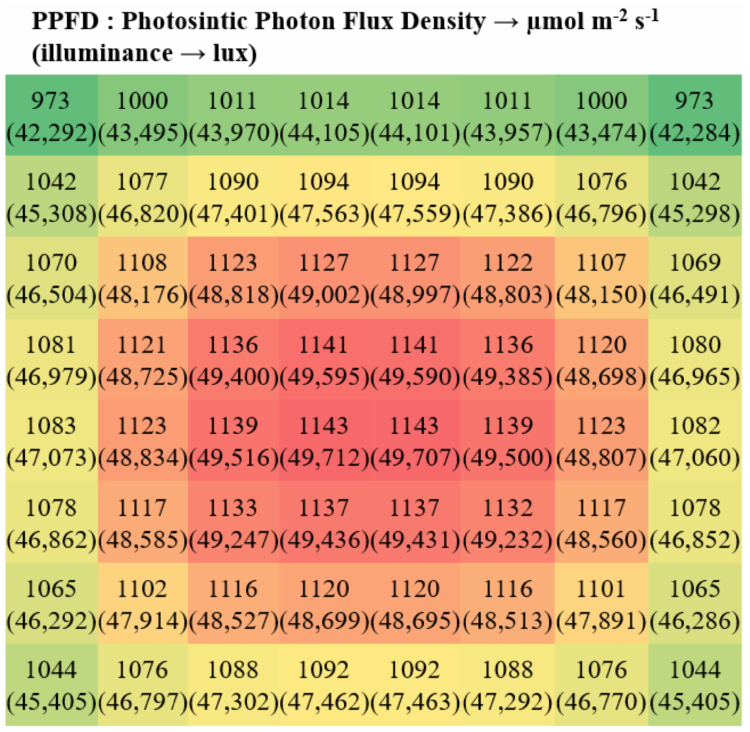
Figure 14. PPFD (illuminance) map of Case